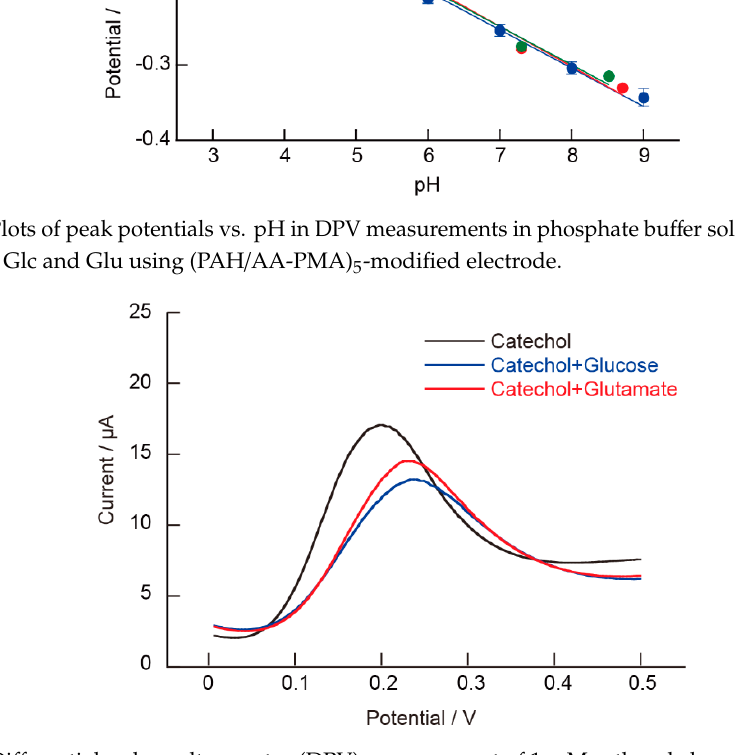
Figure 8. Differential pulse voltammetry (DPV) measurement of 1 mM cathecol absence and presence of 10 mM glucose and glutamate using glassy carbon (GC) electrode (3-mm diameter) in 100 mM phosphate buffer solution at pH 7.4.